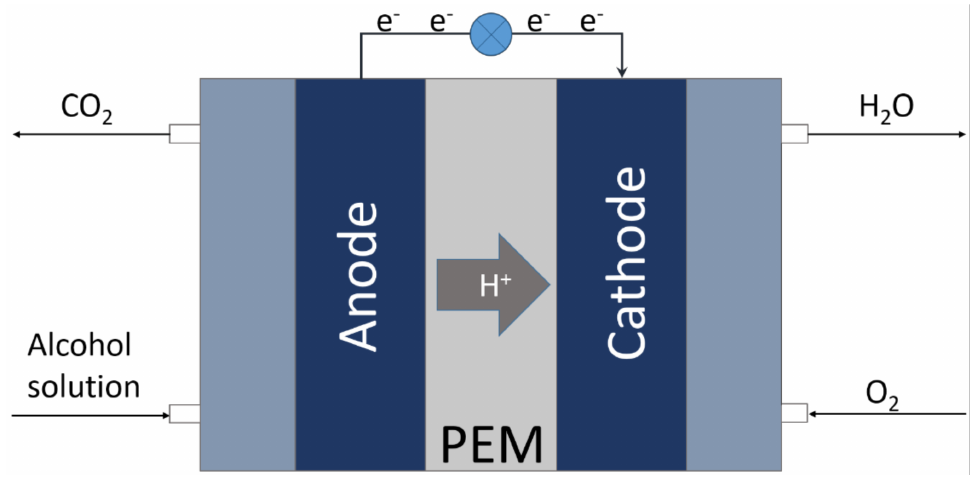
Figure 1. Scheme of a direct alcohol fuel